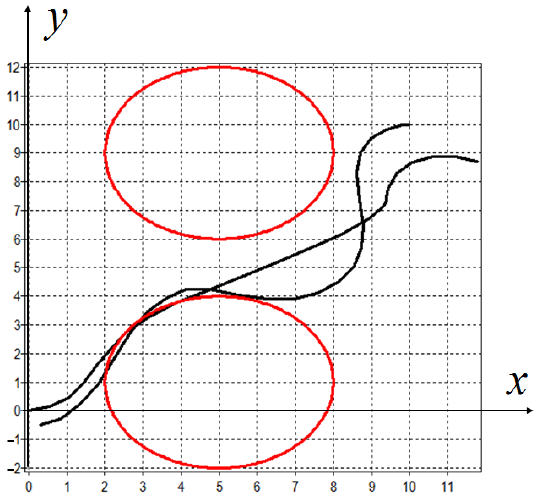
Figure 4. Optimal trajectories of robots on the plane { x , y } for direct control with B =